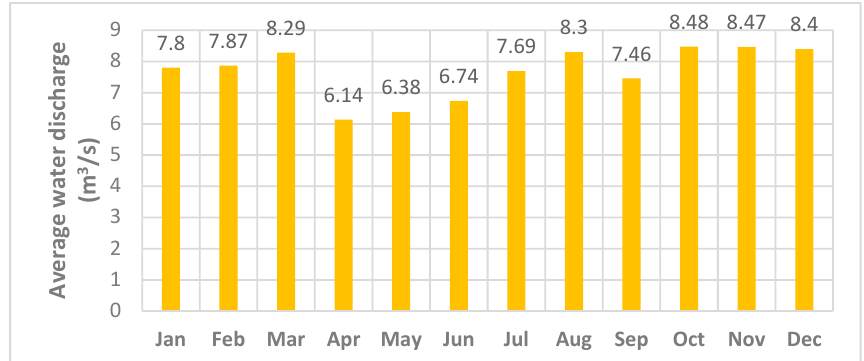
Figure 5. Monthly average ambient temperature for the village of Mboke.